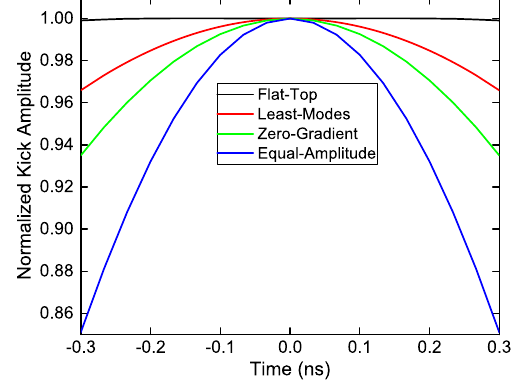
FIG. 4. Comparison of the kicking pulse curvature over þ = − 3 σ of 3 cm kicked electron bunch for the four waveform schemes with a recirculating factor of 10.